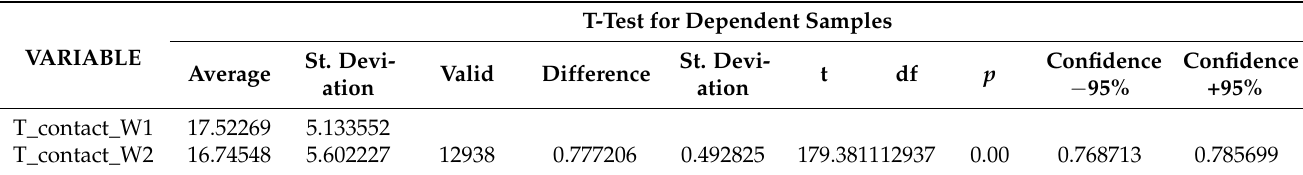
Table 4. Exemplary results for the compliance test in temperature distribution.